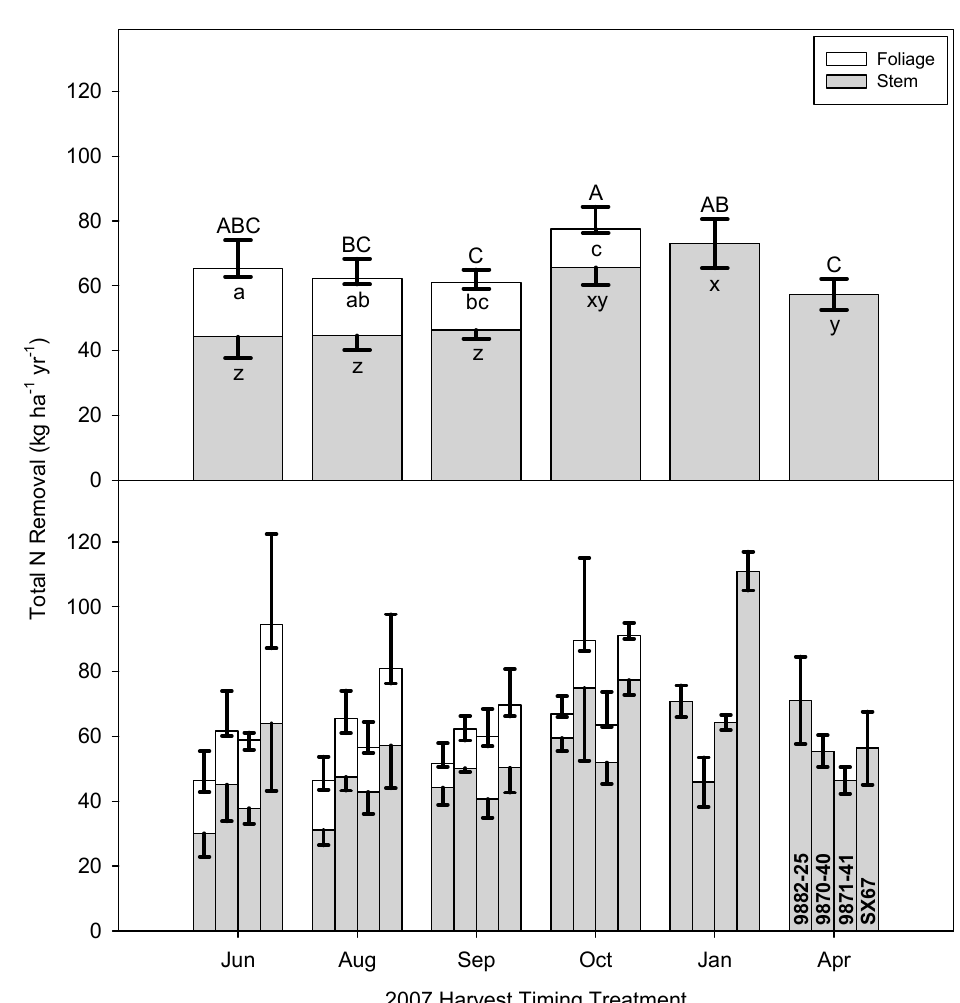
Figure 3. ( Top ) Nitrogen removal (mean ± SE) in the form of stem and foliage biomass for the first rotation time-of-harvest treatments (ToH) that occurred on the prescribed ToH areas between June 2007 and April 2008. Letters indicate significant differences between total removal (upper case A-B-C), foliar removal (lower case a-b-c), and stem removal (lower case x-y-z). One-way error bar indicates the standard error for the arithmetic mean for total biomass (upward), downward in the white space for foliage, and downward in the gray space for stem components. ( Bottom ) Sets of bars showing stem and foliage biomass for individual cultivars as labeled on the rightmost